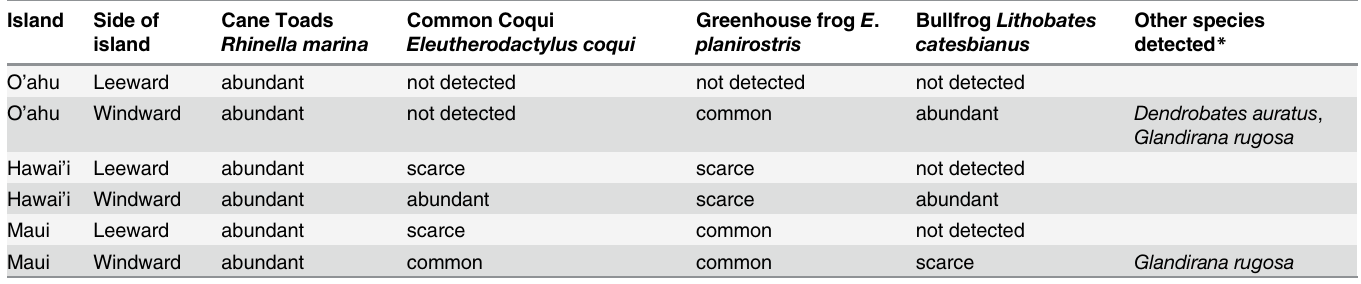
Table 1. Occurrence and relative abundance of anurans encountered during nocturnal surveys on windward and leeward sides of O ’ ahu, Hawai ’ i ( “ the Big Island ” ) and Maui.